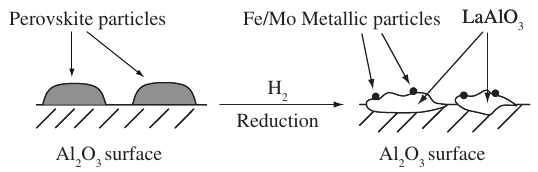
Mn Mo O perovskite: 0.90 0.08 0.02 3